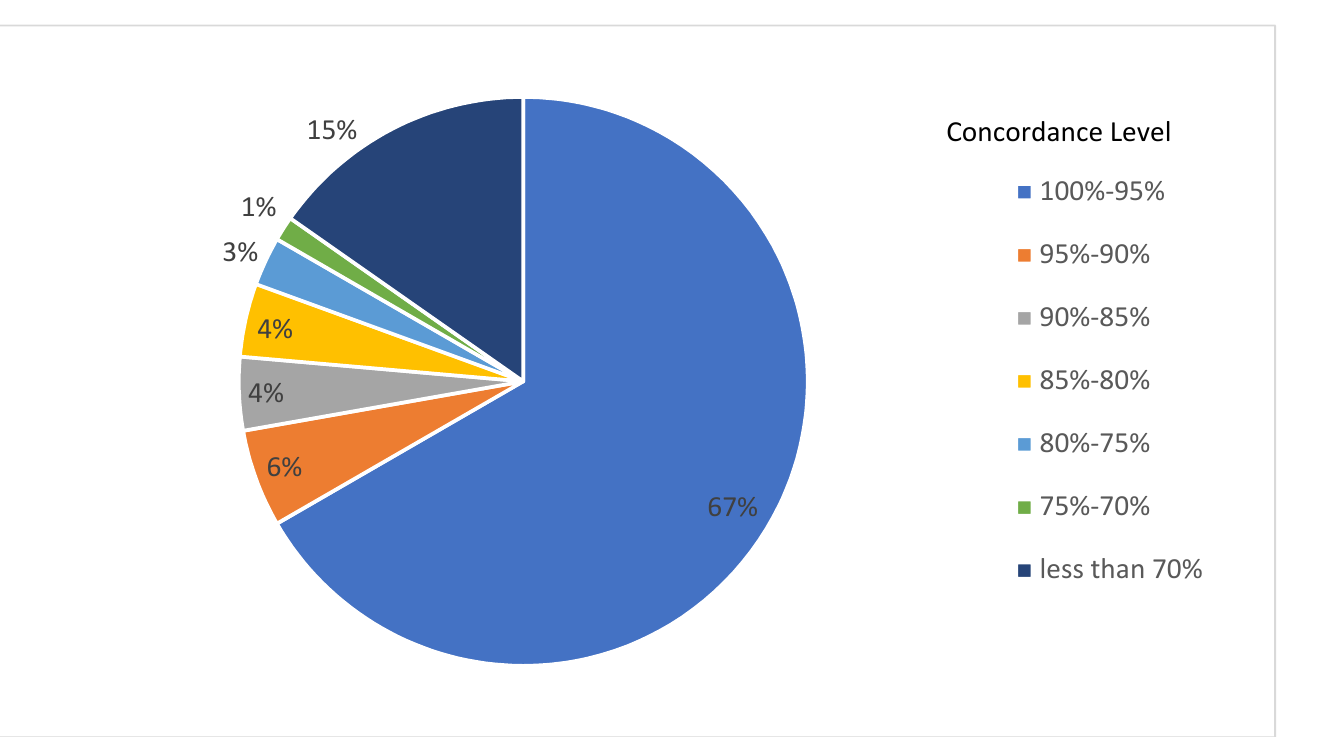
Figure 2. The concordance between the dominant node and its neighbors.